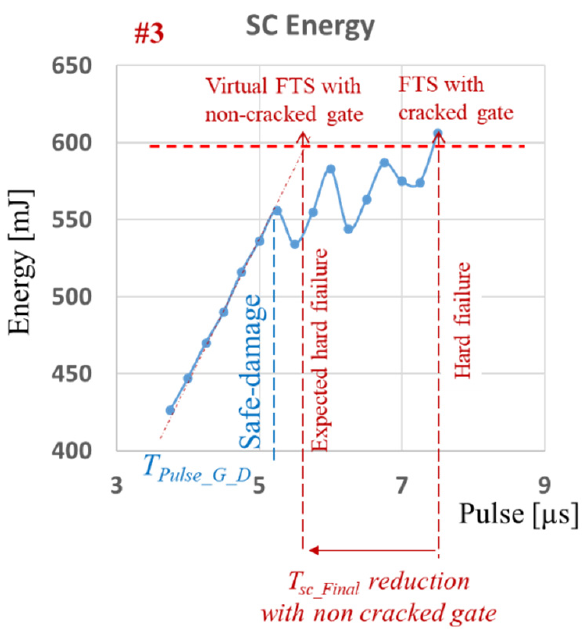
Figure 10. Estimated behavior from the energy extrapolation.